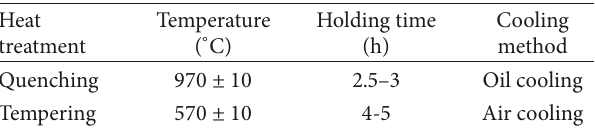
Table 3: Heat treatment